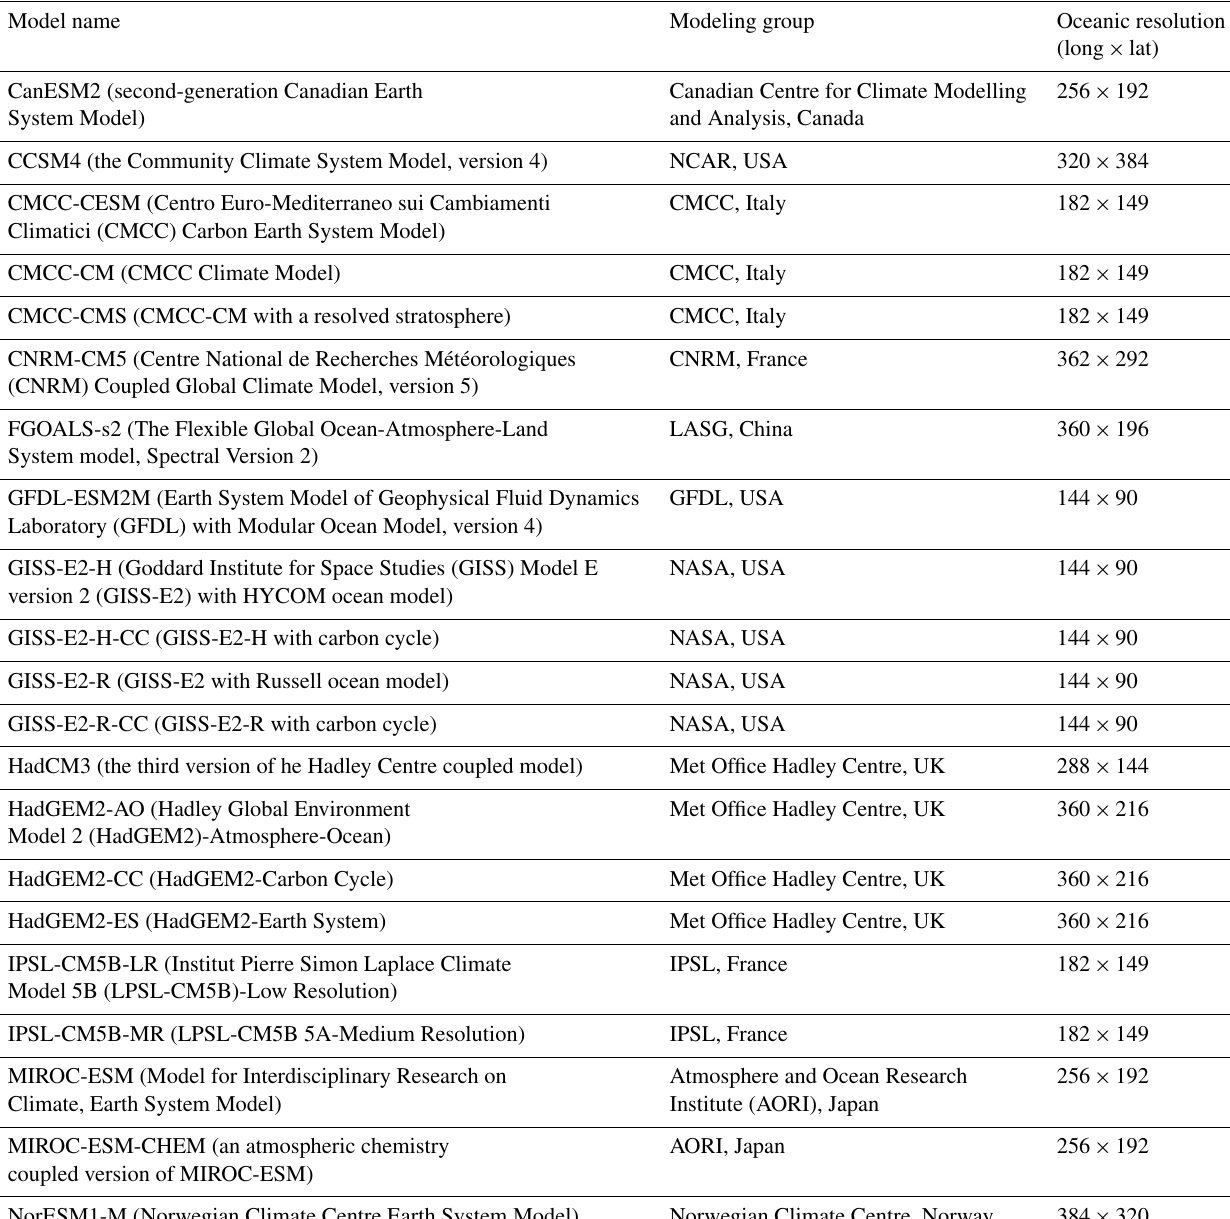
Table 1. List of 21 selected CMIP5 climate